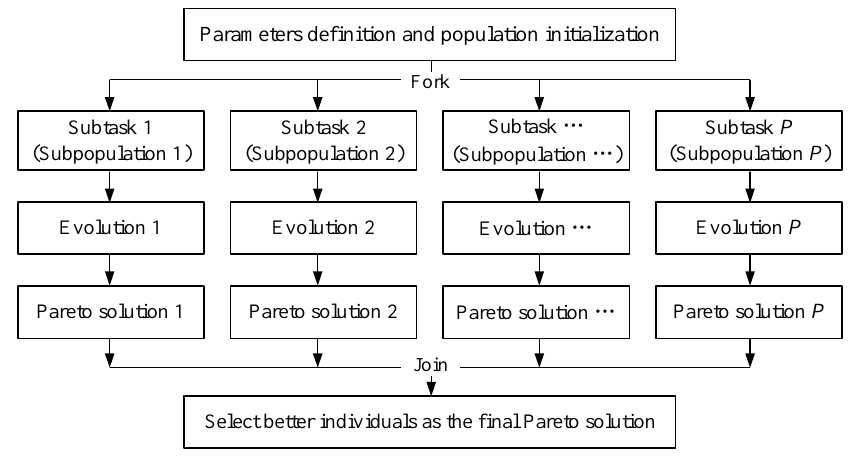
Figure 3. Map of the PMOGA algorithm.